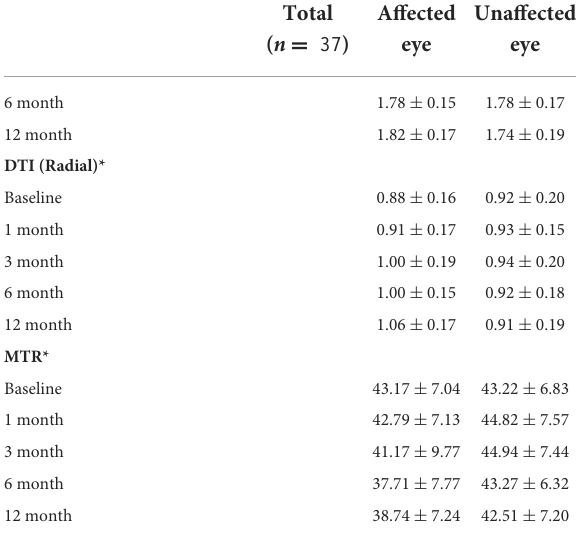
The final multivariate model in Table 2 demonstrated that the best predictors of LCLA 2.5% asymmetry at 6 months were Ishihara and HCVA asymmetry at 1 and 3 months, whereas the best predictors of LCLA 2.5% asymmetry at 12 months were HCVA asymmetry at 1 month and the Ishihara asymmetry at 3 months. Note that only the relevant variables in the final models are included in this table, and subsequent